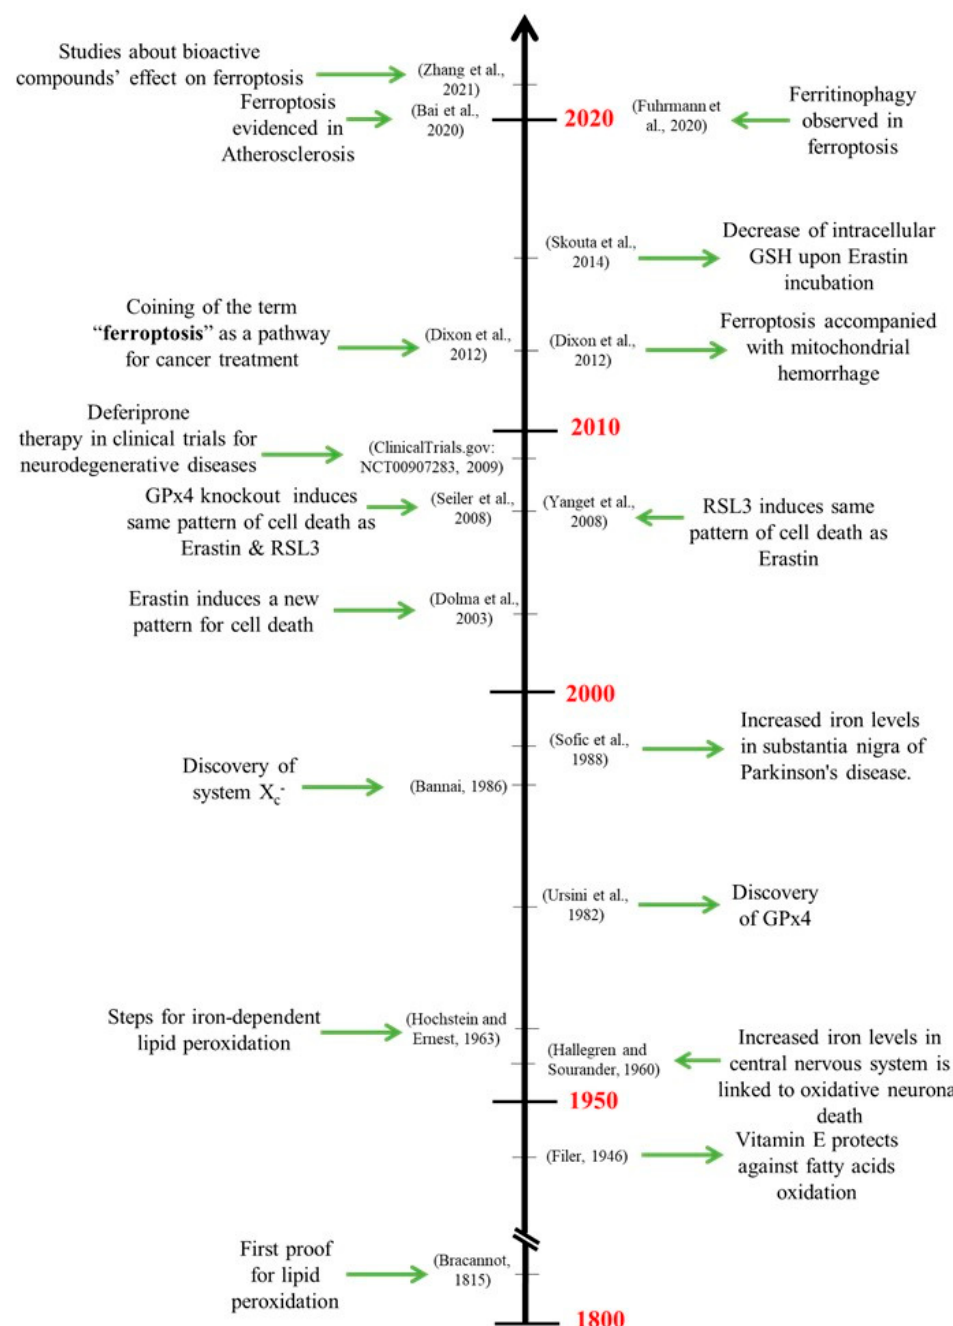
Figure 1. Timeline of the major discoveries concerning ferroptosis